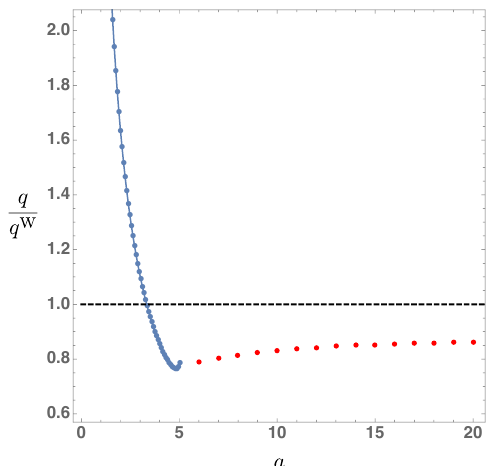
p 3. Similar results